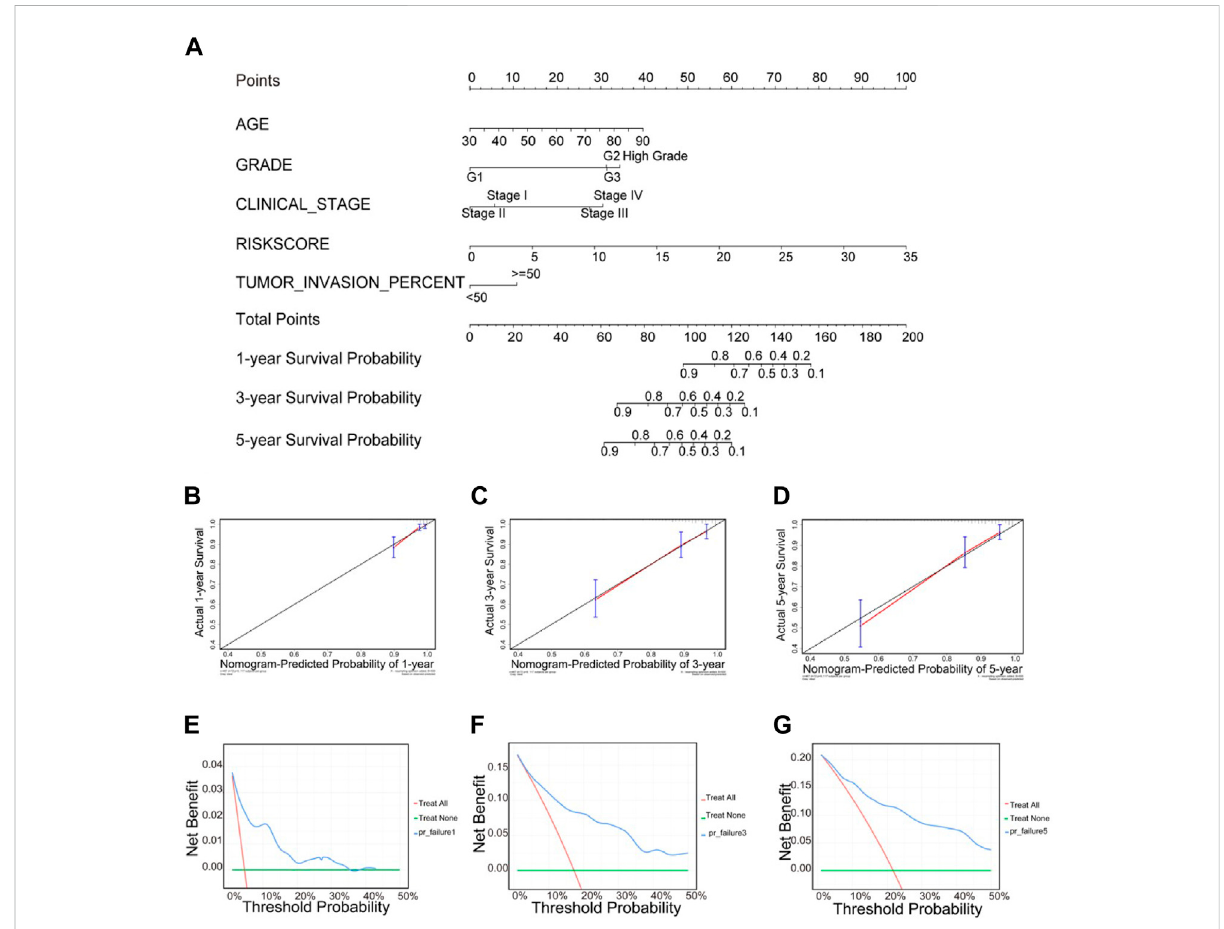
FIGURE 11 ClinicalprognosticnomogramforpredictingprognosisinTCGAUCECcohorts. (A) Theclinicalnomogramdevelopedtopredict1-year,3-years and5-yearssurvivalbyincorporating fi veindependentprognosticindicators,includingriskscore.Calibrationcurvesshowingnomogrampredictions forone-year (B) ,3-years (C) and5-years (D) survival.Decisioncurveanalysiswasusedtoestimateclinicalusefulnessandnetbene fi tofthepredictive nomogram for 1-year (E) , 3-years (F) and 5-years (G)